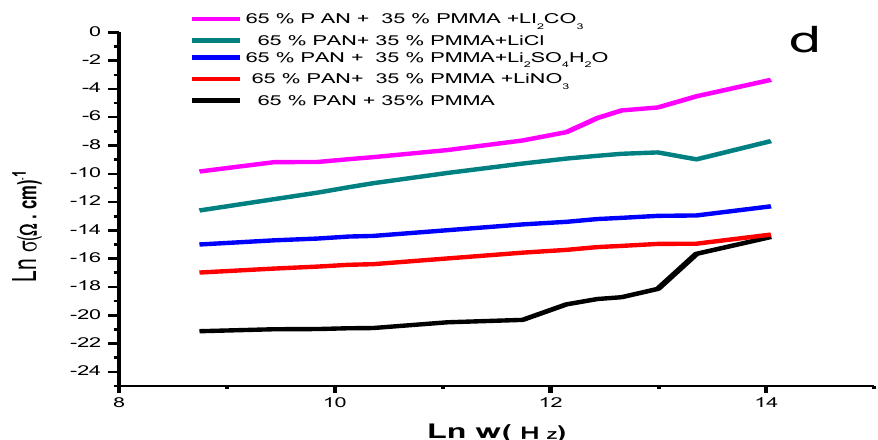
Figure 1 d: Variation of Ln σ (ω) with Ln(ω) for (65%PAN/35%PMMA) and doped with a.c